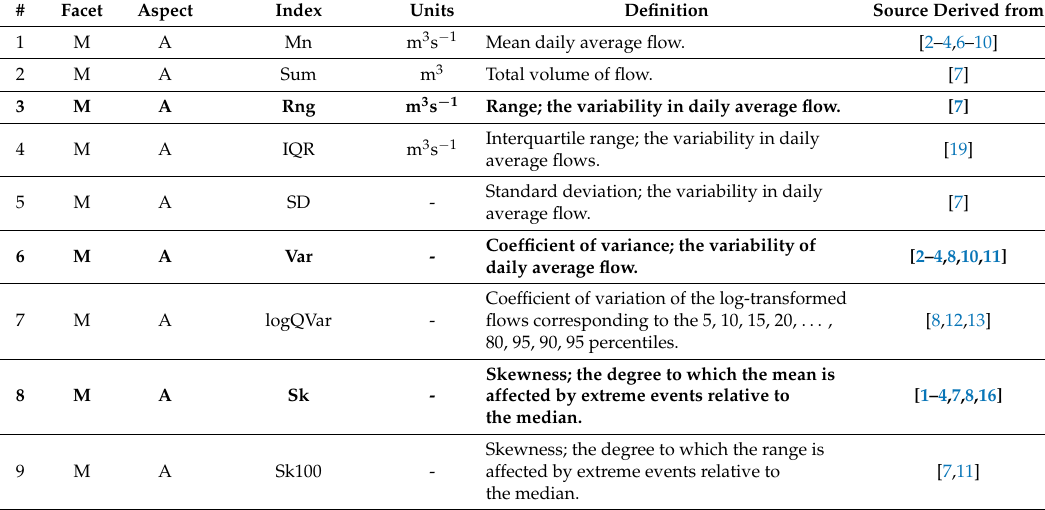
Table A1. Complete list of the 80 ecologically relevant hydrological indices derived per season/site. The number of indices was reduced to those in bold through the application of principal component analysis. Total volume of flow. Range; the variability in daily average